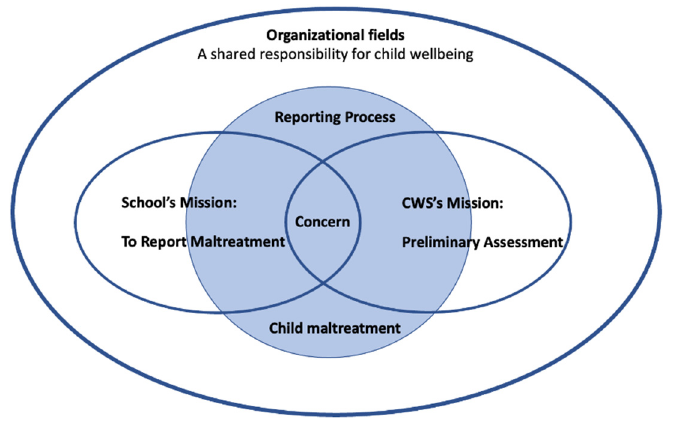
Figure 1. A model of the linked processes in mandatory reporting.